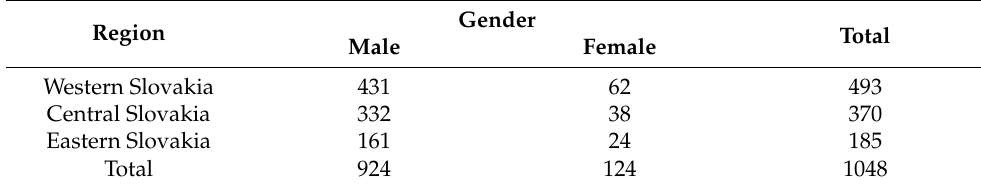
Table 1. Distribution of online survey respondents by region.